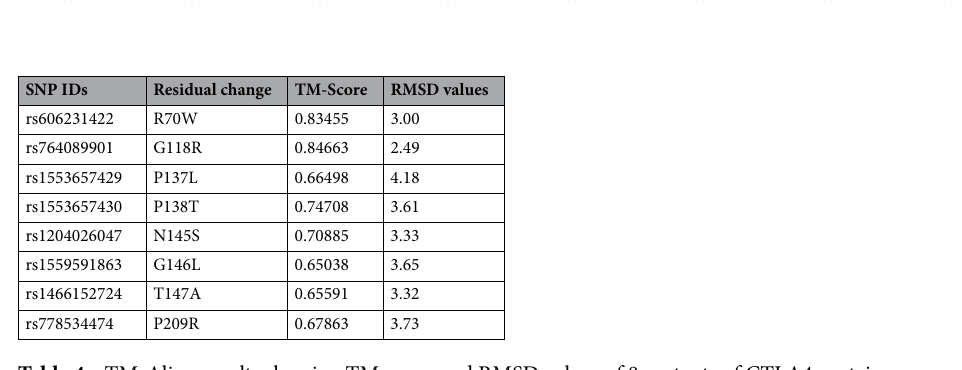
Table 4. TM-Align results showing TM-score and RMSD values of 8 mutants of CTLA4 protein.